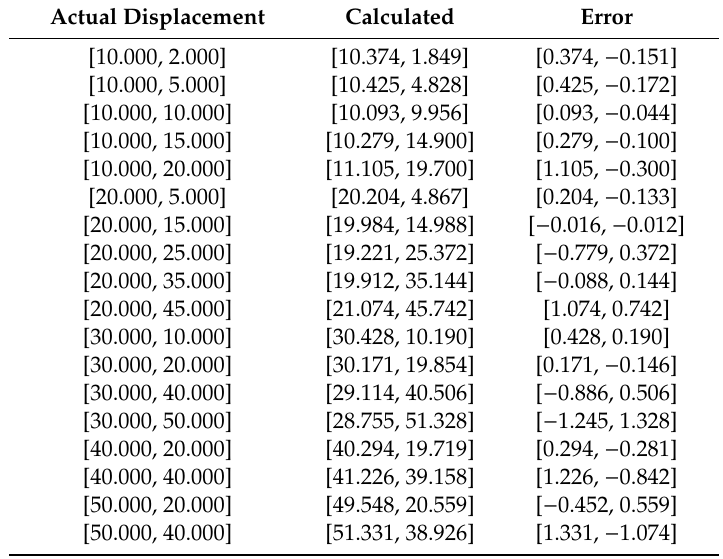
Table 4. Measuring result of [horizontal displacement, vertical displacement] of 20 ◦ tilt angle (unit: